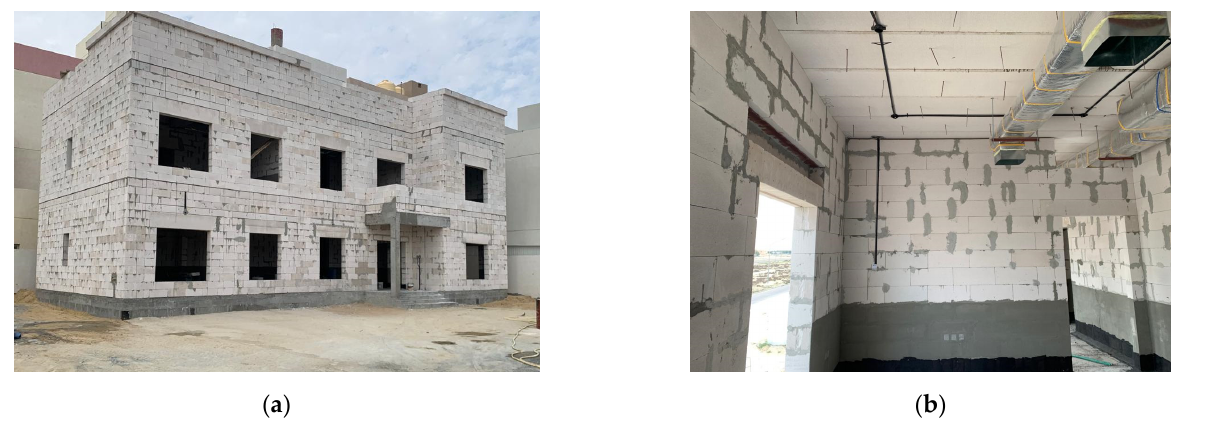
Figure 2. A low-rise house made of unreinforced AAC blocks. ( a ) Exterior view and ( b ) interior view.